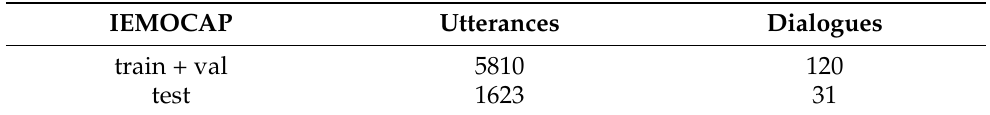
Table 2. IEMOCAP Dataset